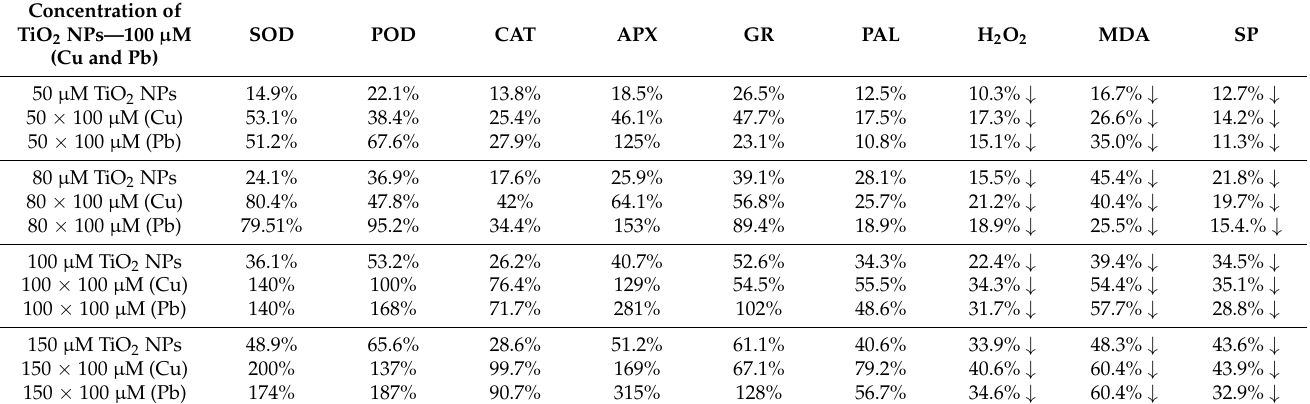
Table 1. The change in antioxidant enzymatic activities and H 2 O 2 , MDA, and soluble protein contents at the various levels of TiO 2 NPs and heavy metals (Cu and Pb) compared to those of the control treatment. The arrows show the percentage reduction of